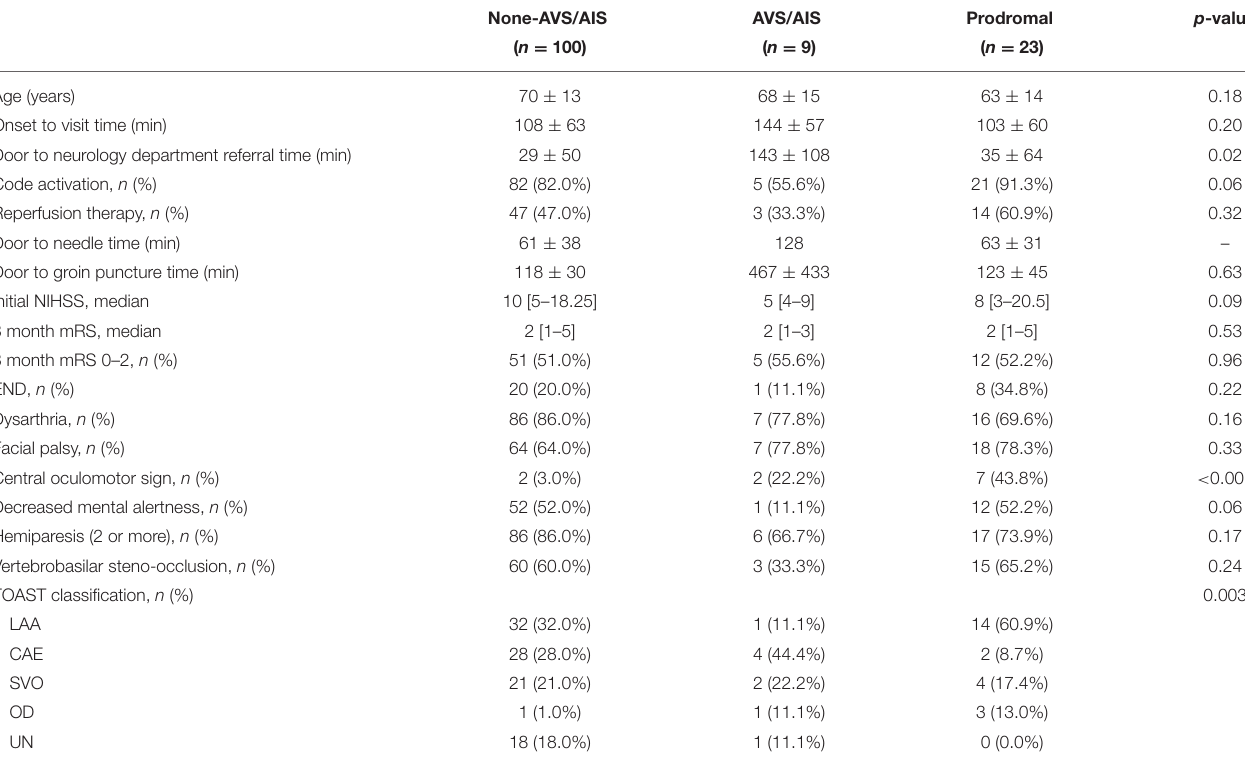
TABLE 5 | Demographics and clinical characteristics of patients with major posterior circulation